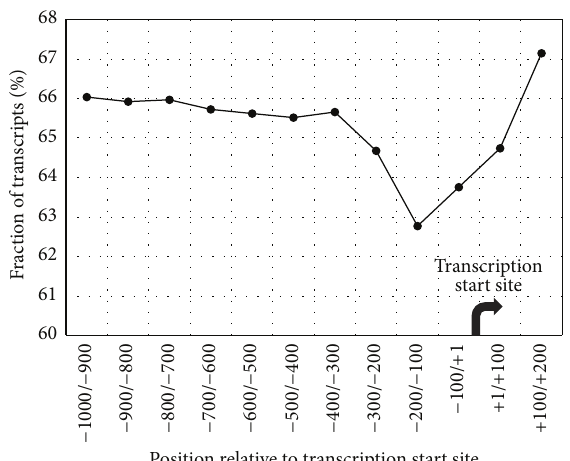
Figure 2: The fractions of transcripts from the whole-genome dataset that do not contain SNPs in their 100 bp long upstream regions as a function of region location. 𝑥 -axis shows the borders of 100bp bins relative to the TSS. 𝑦 -axis means the fraction of transcripts that lack SNPs in the respective 100bp